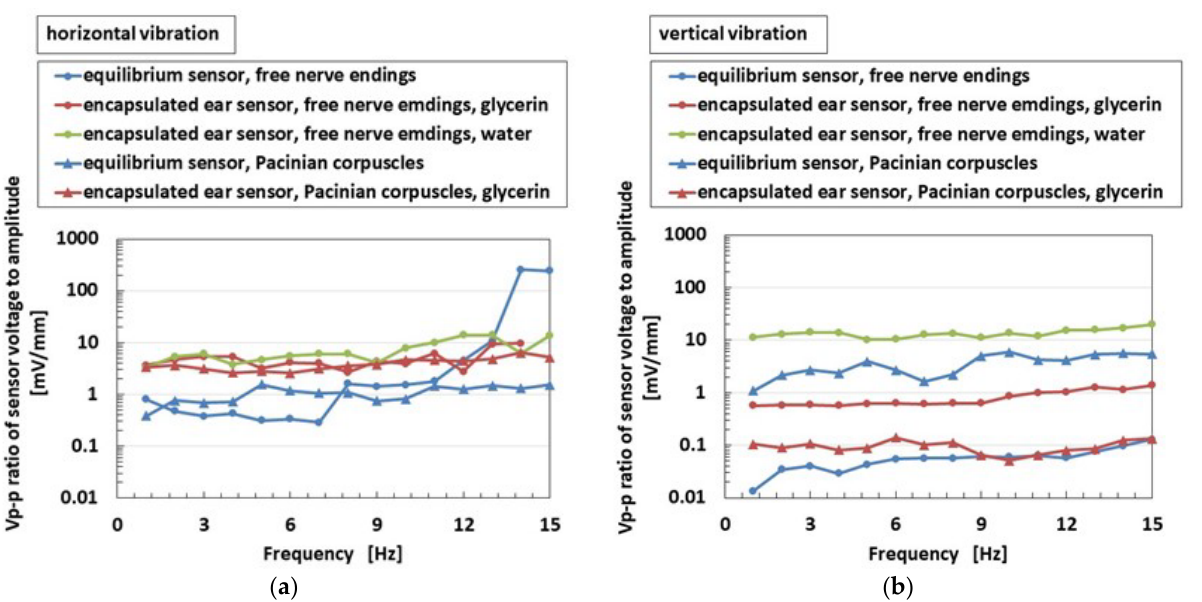
Figure 14. Experimental results of the vibrating auditory sensor by a mechanical vibrator when the vibration directions are compared: ( a ) horizontal vibration and ( b ) vertical vibration.